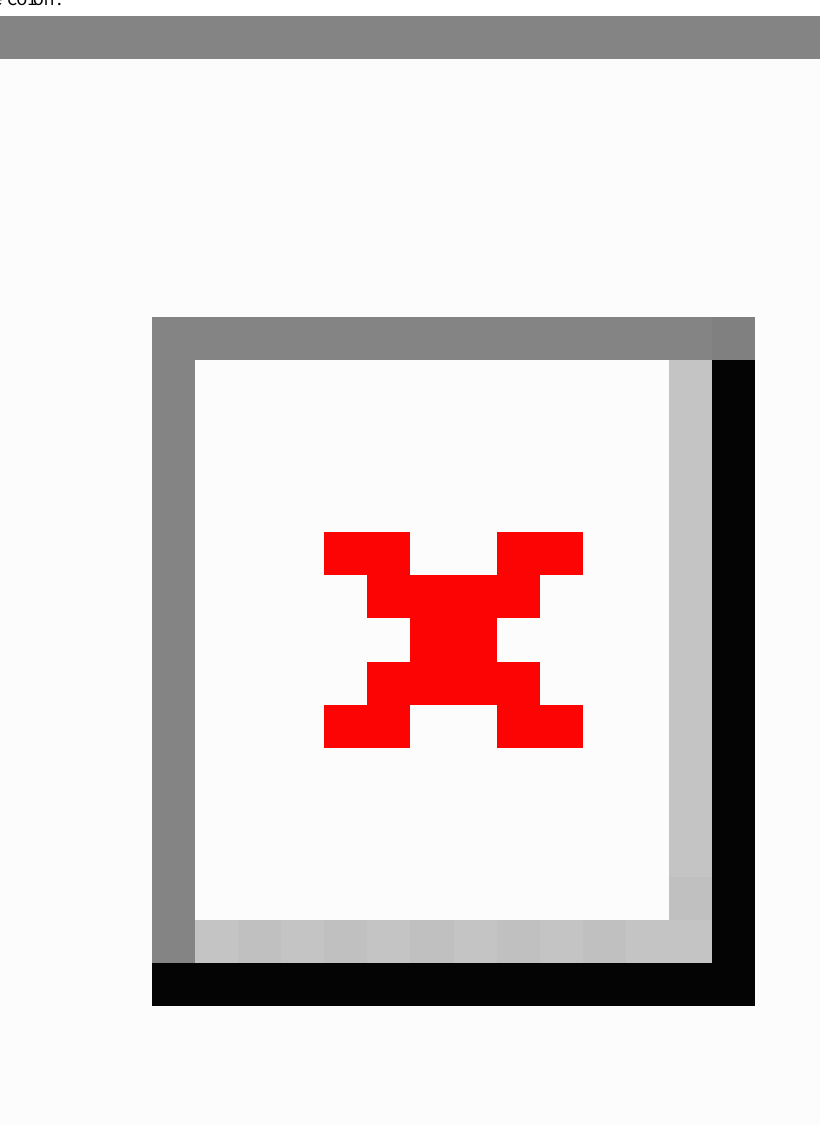
Figure 4. Average Boston bowel preparation scale score split into colonic regions (left, transverse, and right colon) with a significantly higher score for left and transverse